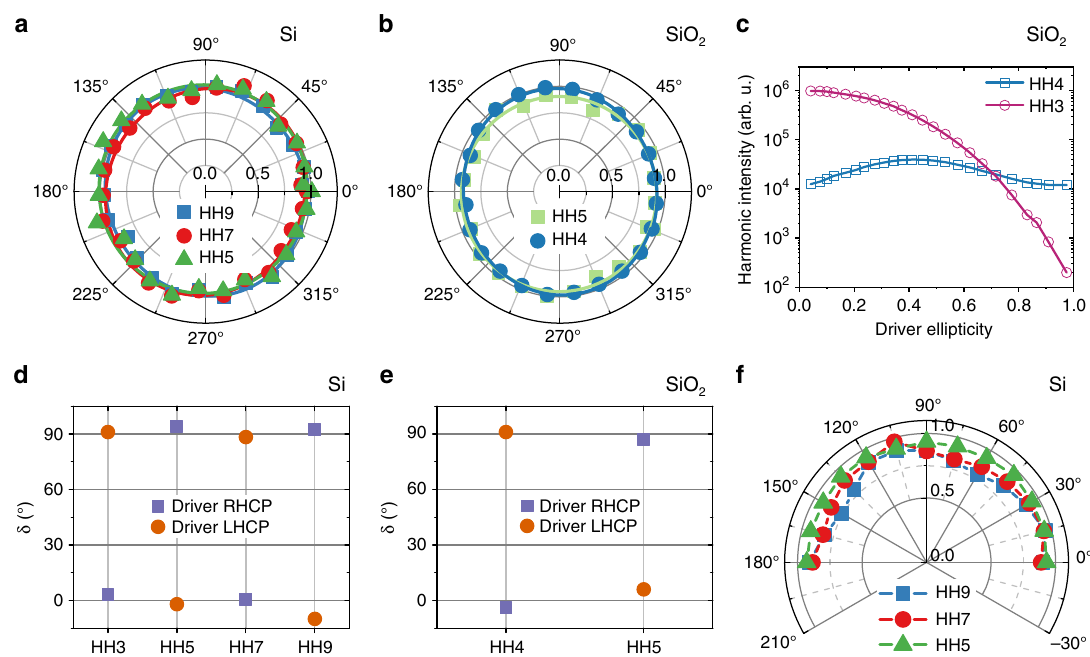
Fig. 2 Measured circular harmonics from a circular driver and selection rules. Normalized harmonic intensity versus polarizer rotation angle from silicon ( a ) and quartz ( b ), showing circular harmonics. The solid lines are sin-square fi ts. c Intensity of HH3 and HH4 from quartz versus driver ellipticity. Harmonic major-axis rotation after a second quarter-wave plate for silicon ( d ) and quartz ( e ), indicating alternating helicities (RHCP/LHCP, right/left-handed circular polarization) with harmonic order, consistent with selection rules. f Harmonic ellipticities | ε HH | from Si versus sample